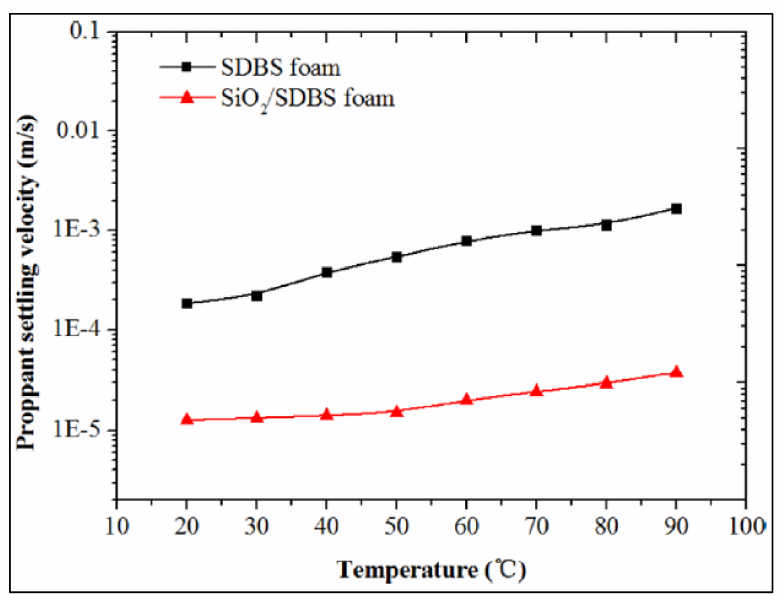
Figure 28. Proppant settling velocity against temperature (Adapted with permission from Lv et al. [47]). Copyright 2015, American Chemical Society.